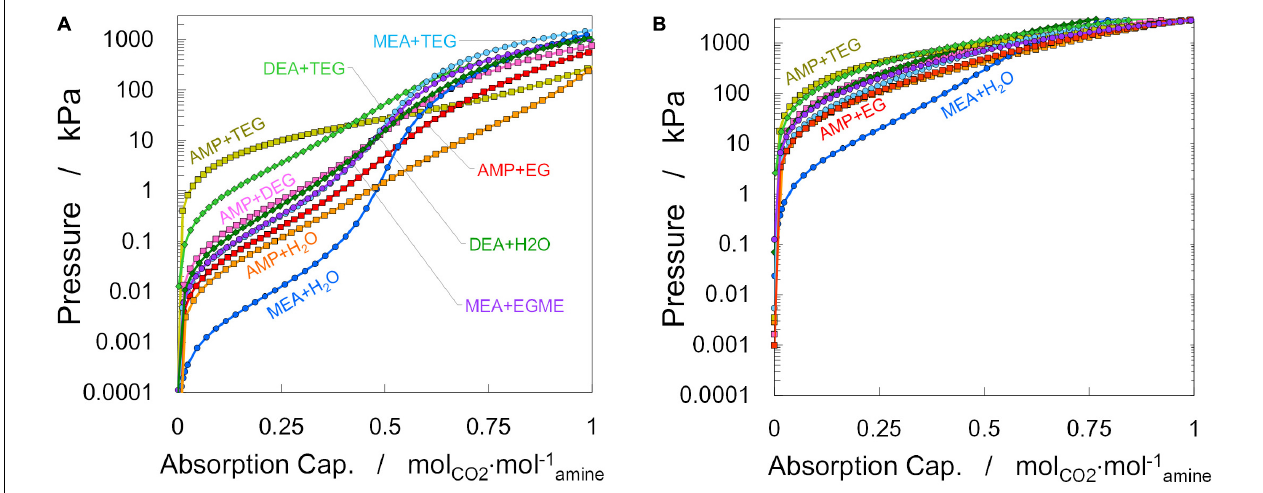
FIGURE 3 | Comparison of calculated partial pressure of CO 2 as function of CO 2 absorption capacity (solubility) in aqueous and non-aqueous amine-based solutions (30 wt%) at different temperatures: (A) 313 K and (B) 393